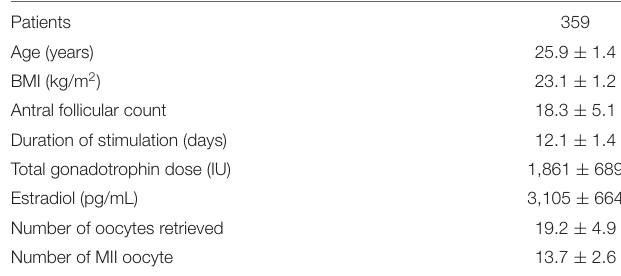
TABLE 1 | General demographics of the oocyte donor population included in the